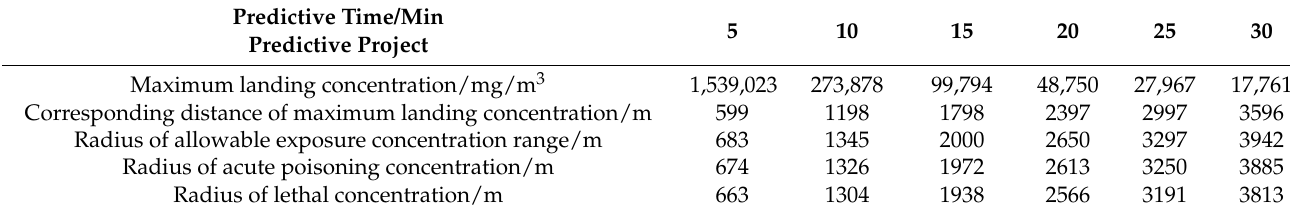
Table 3. Statistical table of prediction results of HF leakage and diffusion with E level atmospheric stability. Predictive